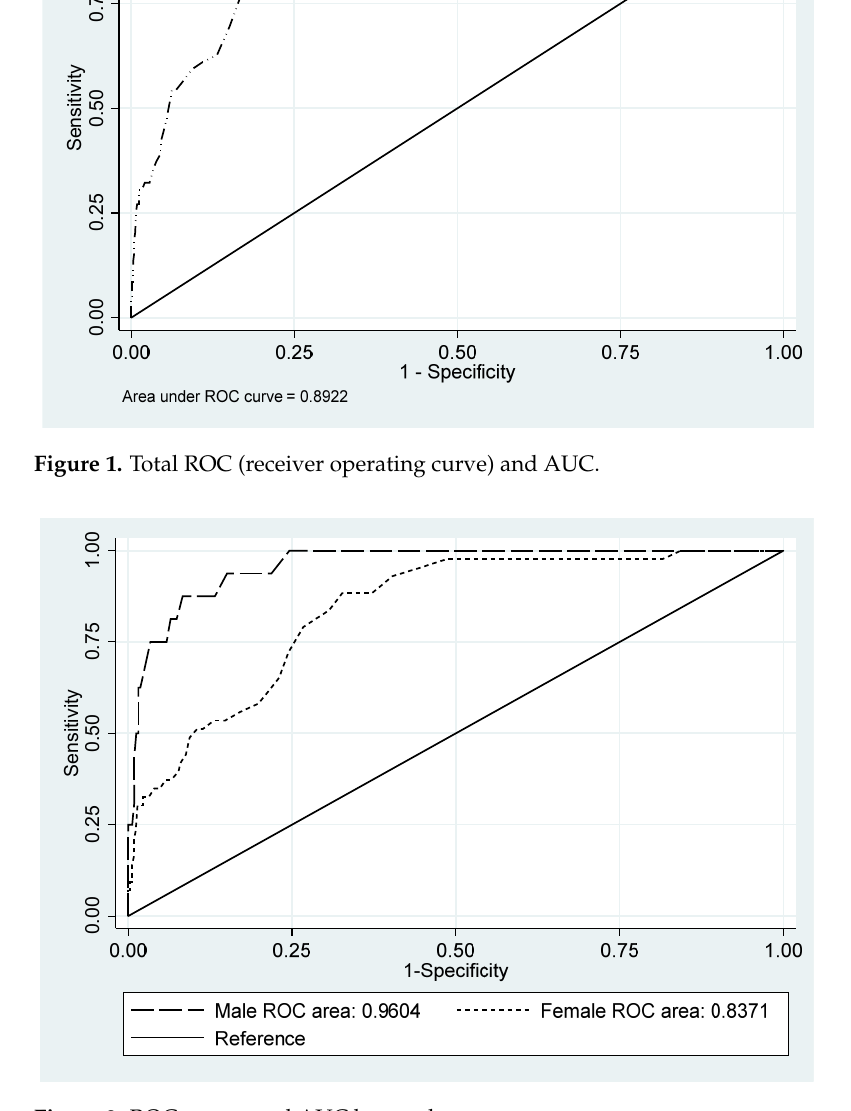
Figure 2. ROC curves and AUC by gender.